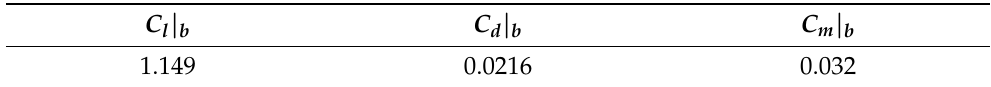
Table 3. Aerodynamic coefficients of the NLR 7301 airfoil at α = 10.1 ◦